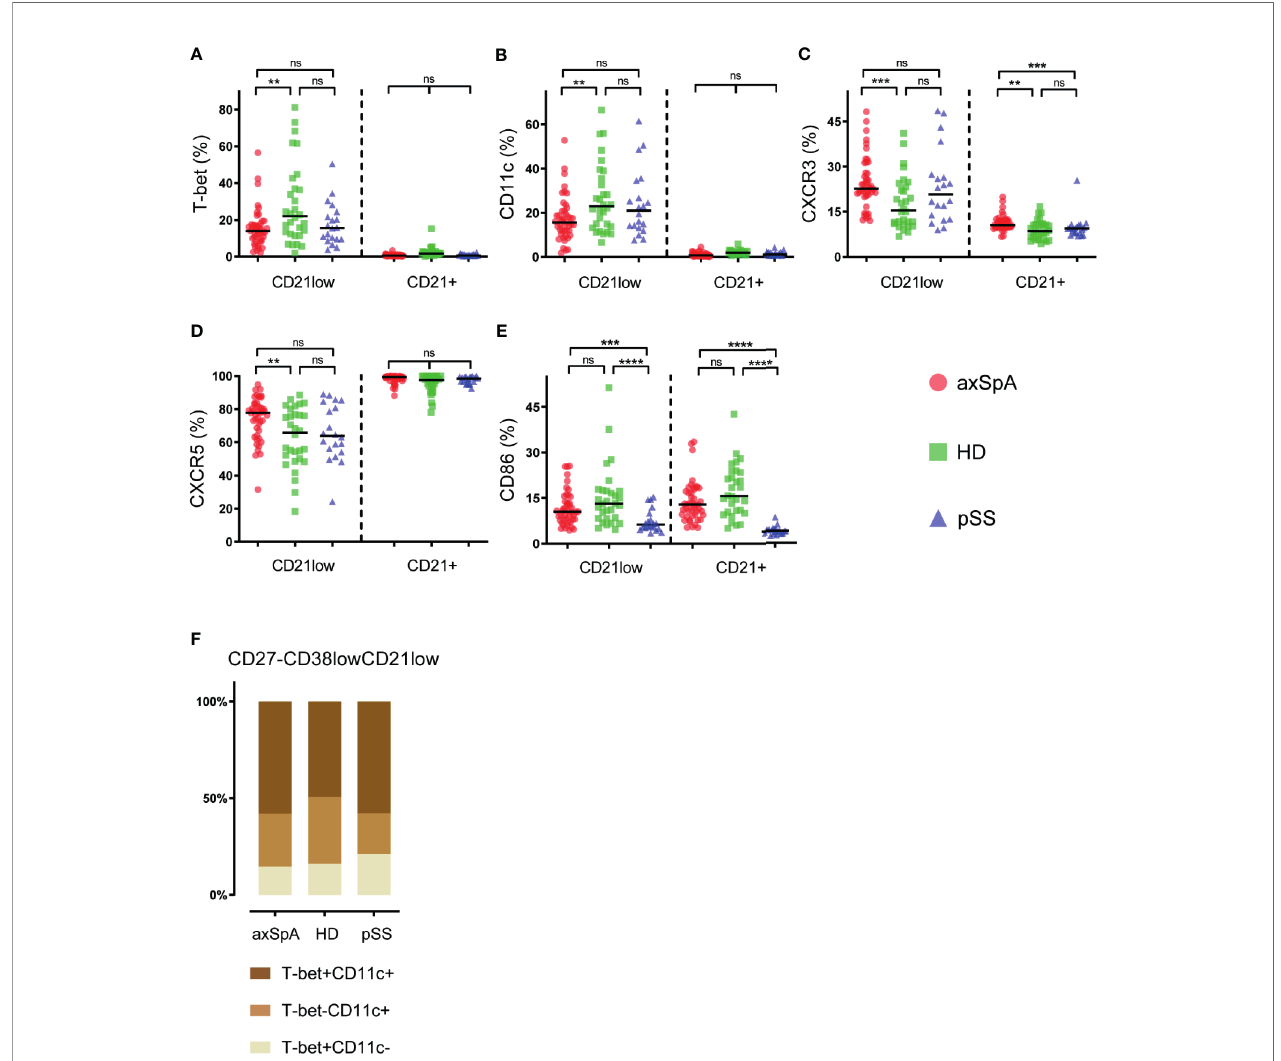
FIGURE 2 | Phenotypical characteristics of CD27 - CD38 low CD21 low B-cells in patients with axSpA, pSS and healthy donors. The proportions of (A) T-Bet-positive, (B) CD11c-positive, (C) CXCR3-positive, (D) CXCR5-positive, (E) CD86-positive cells were analyzed within the CD27 - CD38 low CD21 + and CD27 - CD38 low CD21 low B- cell subsets. In addition, (F) an illustration of T-bet/CD11c co-expression by CD27 - CD38 low CD21 low B-cells is displayed. Patients with axial spondyloarthritis (axSpA; n = 45) are indicated with red circles, healthy donors (HD; n = 30) are indicated with green squares and patients with primary Sjögren ’ s Syndrome (pSS; n = 20) are indicated with blue triangles. **P < 0.01, ***P < 0.001, ****P < 0.0001, ns, not signi fi cant and horizontal lines indicate the